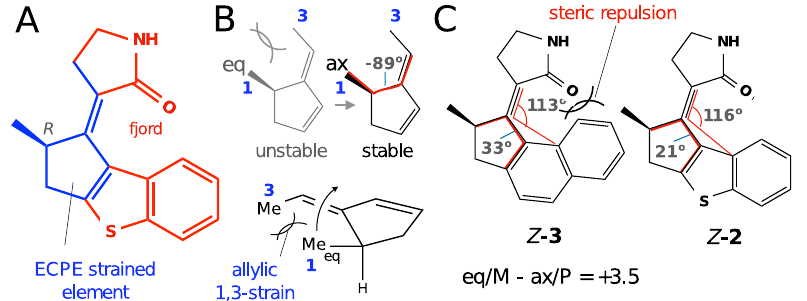
Fig. 7 | Illustration of the factors contributing to absence of the stable M conformations in MTDP. A Z - 2 structure highlighting the strained unit (blue) and the clashing fjord region (red). B Pictorial illustration of the equatorial to axial relaxation imposed by the strain in a model of the ECPE unit. In the equatorial position the Me in position 1 isalmost parallel/aligned with the methyl substituent E M con fi guration before fi nally generating the starting diastereoi- somer E P.